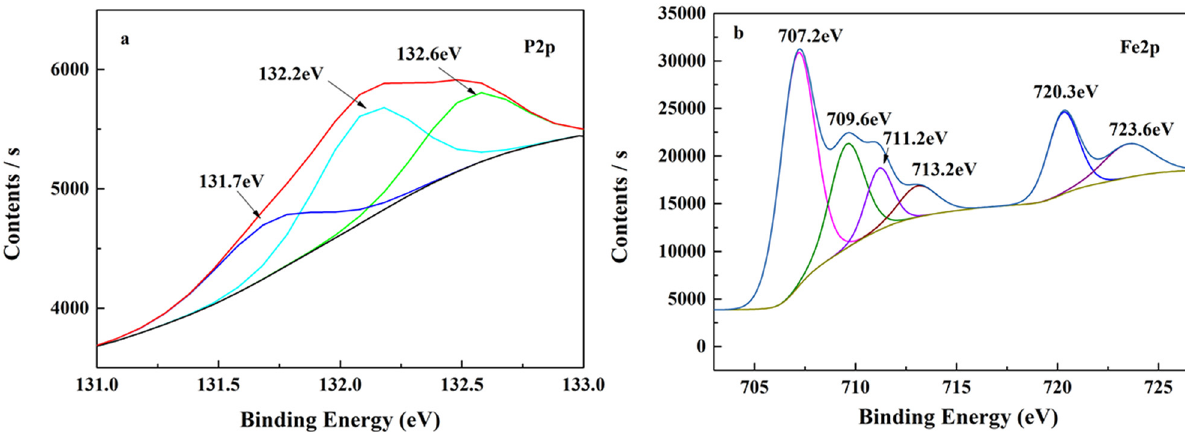
Figure 14: XPS spectra of cross - section of the EL@AR - P 2 coating: ( a ) P, ( b )